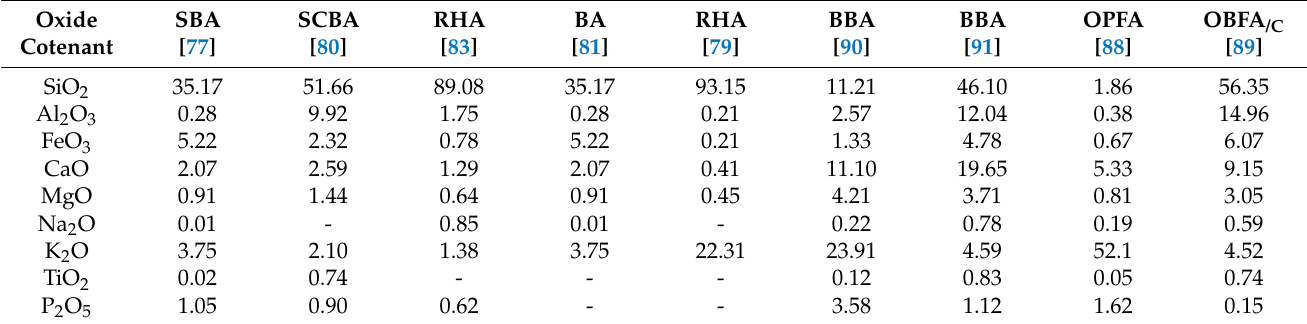
Table 4. The chemical make-up of various lignocellulosic biomass ashes used in the production of unfired clay bricks.